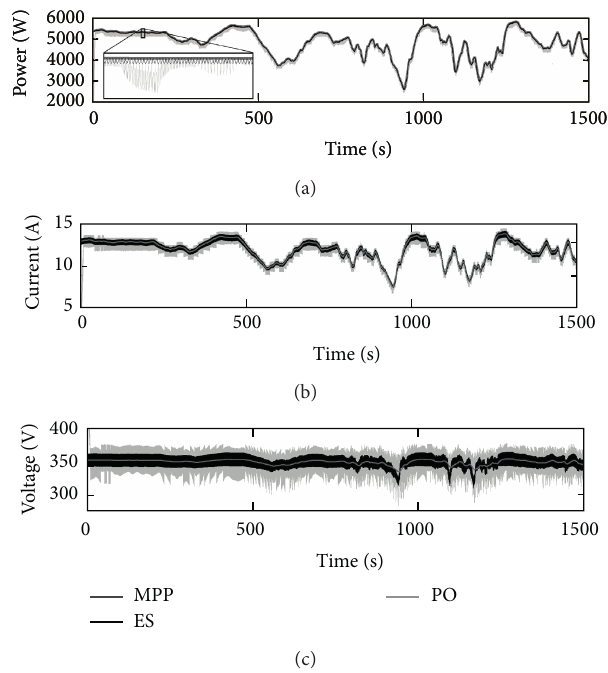
Figure 3: Comparison of current controlled P&O and ESC MPPT controller [3].